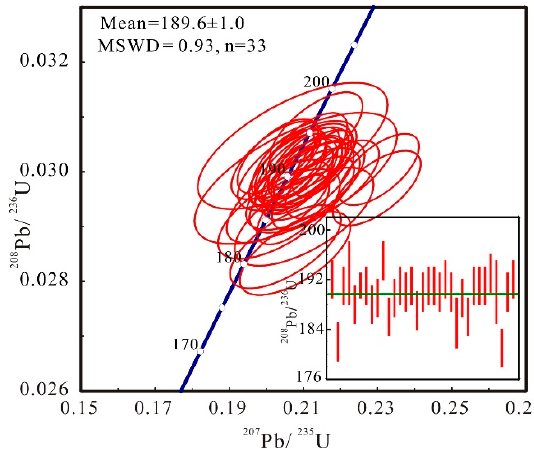
Figure 4. Zircon U-Pb age concordia diagram.